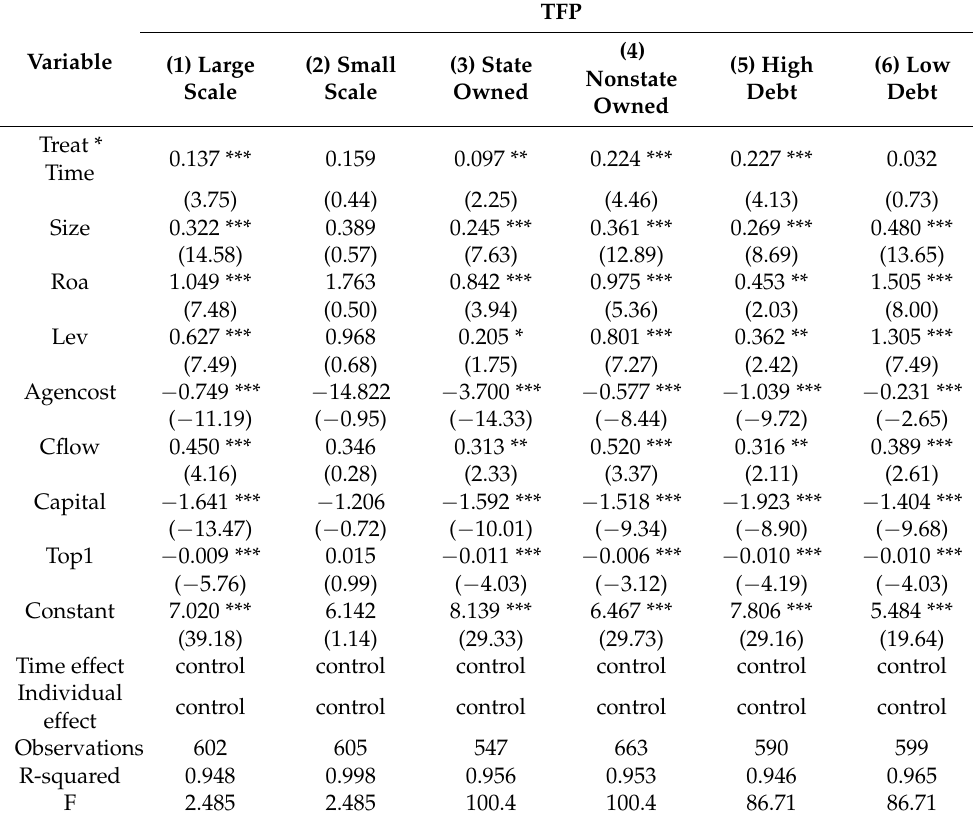
Table 7. The first set of tests for